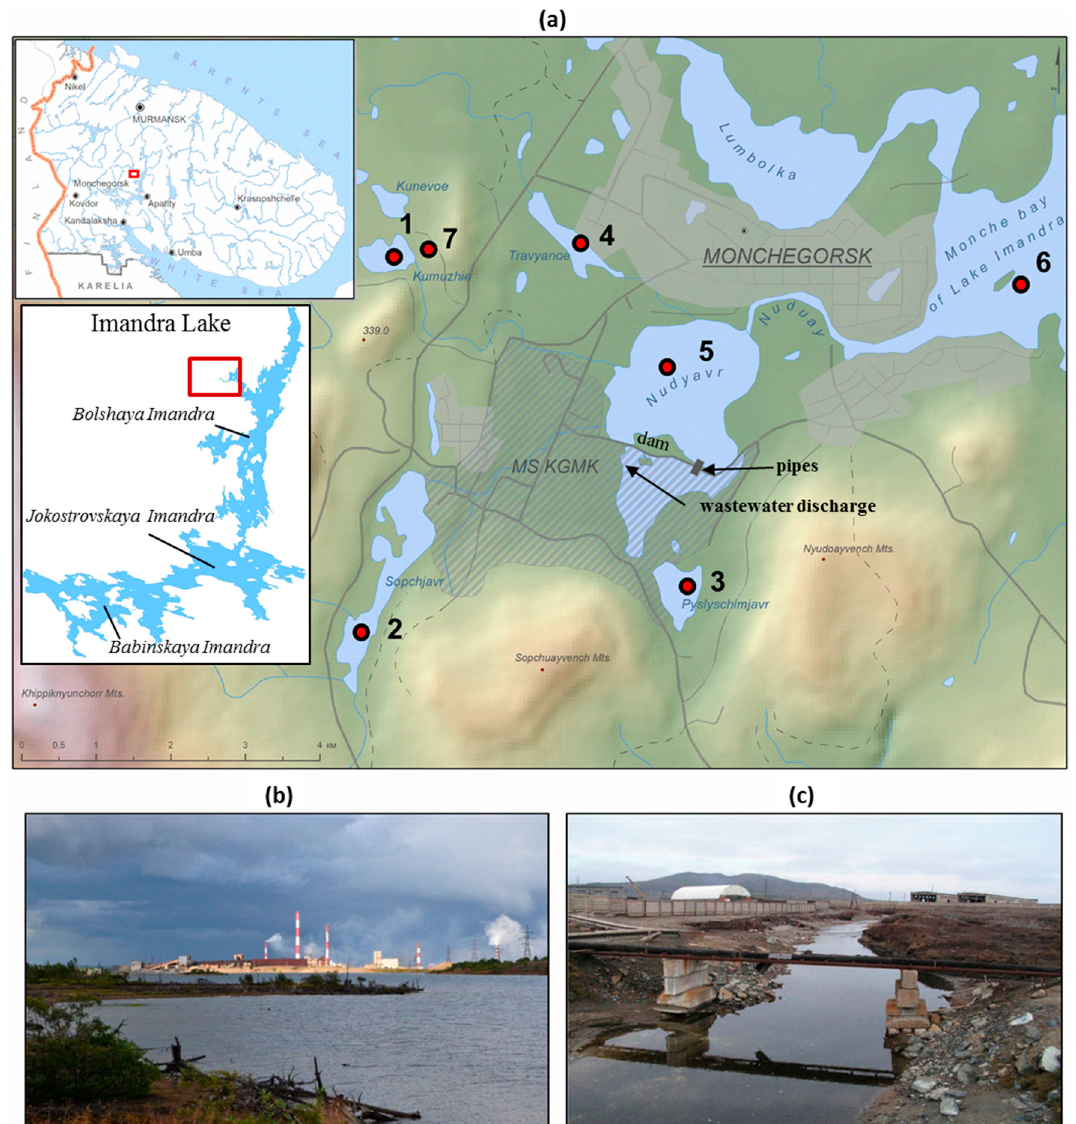
Figure 1. ( a ) The water bodies studied and sampling points; ( b ) a view of MS KGMK from Lake